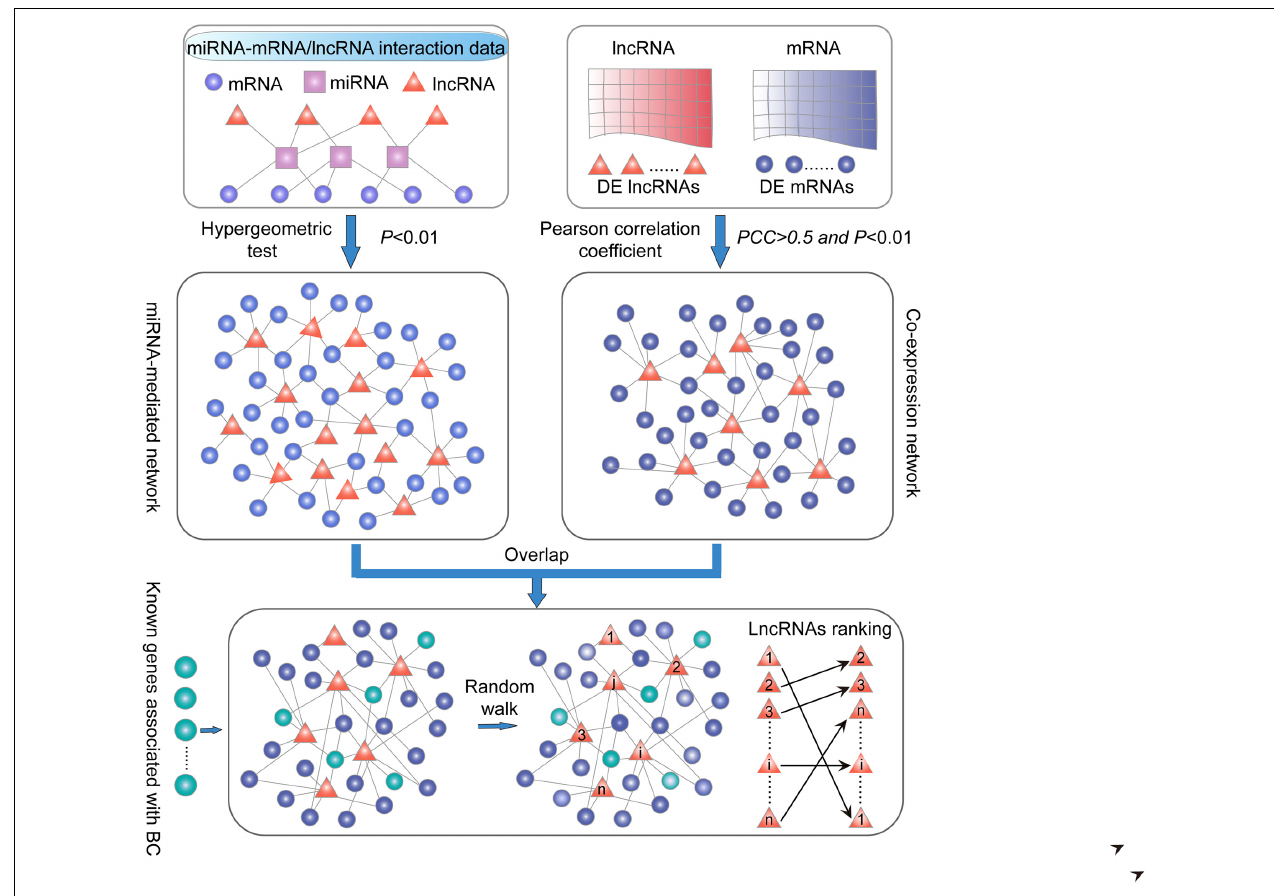
FIGURE 1 | Schematic overview in this study. (i) LncRNA–PCG ceRNA network. PCG and lncRNA shared at least one common miRNA and considered that a P -value < 0.01 was significant by applying the hypergeometric test. (ii) LncRNA–PCG co-expression network. The correlation of co-expression between DE PCGs and lncRNAs using the PCC (PCC > 0.5 and P < 0.01). (iii) Extracted common lncRNA–PCG pairs in (i) and (ii) to structure SLGCeNBC. (iv) The BRCA-associated known PCGs (seed nodes) were mapped into the SLGCeNBC, and the RWR method was performed on this network. Finally, we the ranked candidate lncRNAs according to the steady probability of